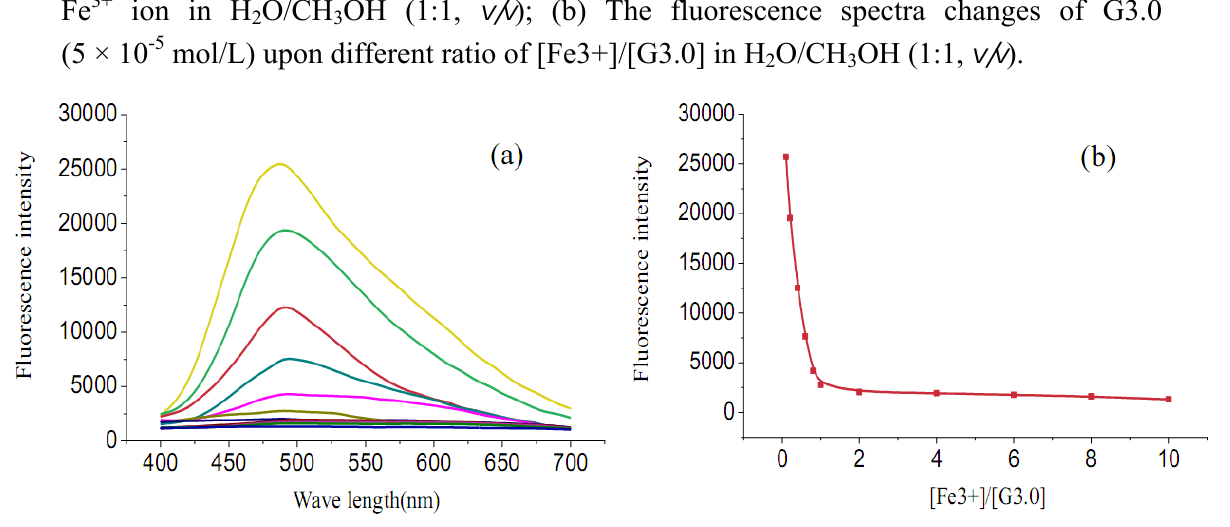
Figure 5. (a) The fluorescence spectra changes of G3.0 (5 × 10 -5 mol/L) upon addition of Fe 3+ ion in H O/CH OH (1:1, v/v ); (b) The fluorescence spectra changes of G3.0 2 3 (5 × 10 -5 mol/L) upon different ratio of [Fe3+]/[G3.0] in H